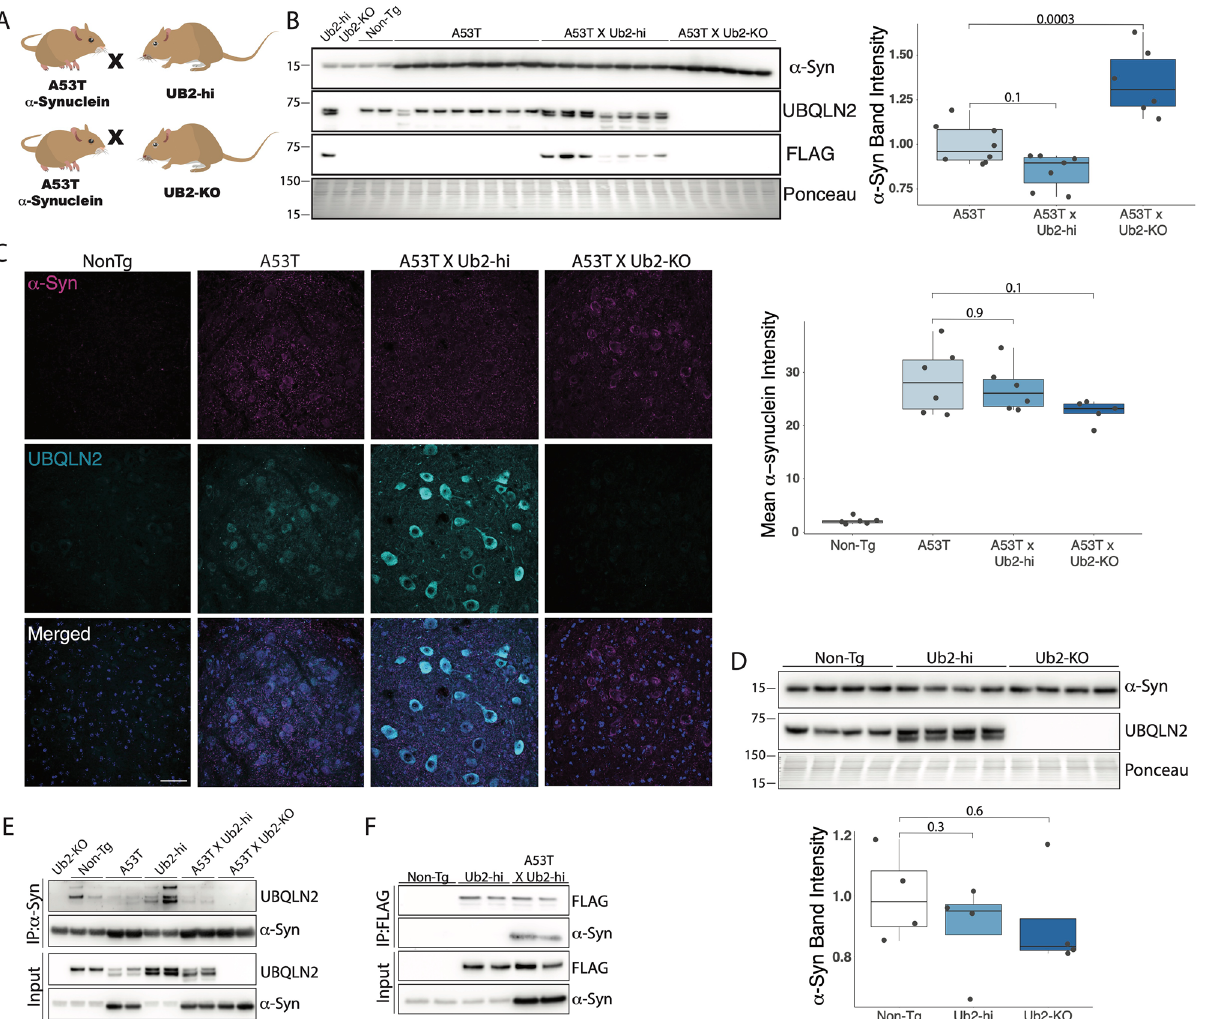
Figure 4. UBQLN2 interacts with and may alter α-syn levels in A53T mice. ( A ) Schematic depicting breeding strategy to obtain A53TxUb2-hi and A53TxUb2-KO mice. ( B ) Western blot of RIPA-soluble brain lysates showing increased levels of total α-syn in A53TxUb2-KO mice (n = 6), while A53TxUb2-hi (n = 7) mice show a trend toward decreased α-syn levels compared to non-transgenic (Non-Tg) controls (n = 8). ( C ) Representative images of total a-syn (magenta) and UBQLN2 (cyan) immunofluorescence in the deep cerebellar nucleus of 12-month-old Non-Tg (n = 6), A53T (n = 6), A53TxUb2-hi (n = 6), and A53TxUb2-KO (n = 5) mice and quantification show no significant difference in total a-syn expression between genotypes. ( D ) Western blot showing total endogenous α-syn levels were unchanged in both Ub2-hi (n = 4) and Ub2-KO mice (n = 4) compared to Non-Tg controls (n = 4). Western blots were cropped to focus on protein(s) of interest. Uncropped Western blots are shown in Supplemental Figure S3). ( E ) Immunoblot showing endogenous and transgenic UBQLN2 is pulled down when α-syn is immunoprecipitated from mouse brain lysate (n = 4). ( F ) Immunoblot showing α-syn coprecipitates with FLAG-tagged UBQLN2 in A53TxUb2-hi mice when FLAG is immunoprecipitated from mouse brain lysate (n =